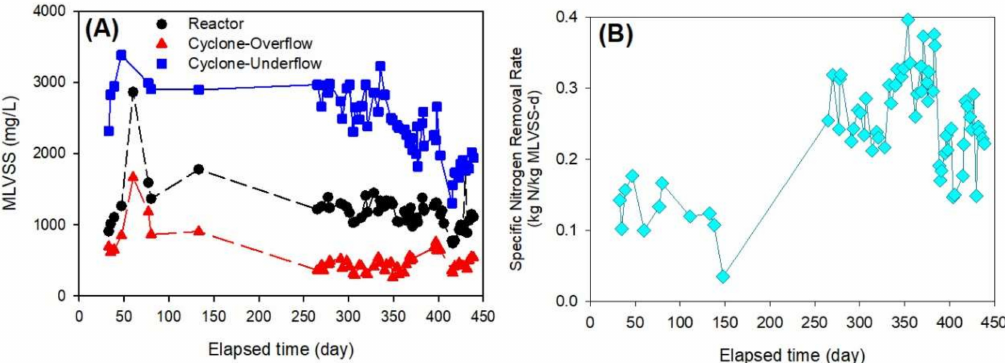
Figure 3. Daily changes in the MLVSS concentration ( A ) and the specific nitrogen removal rate ( B ).